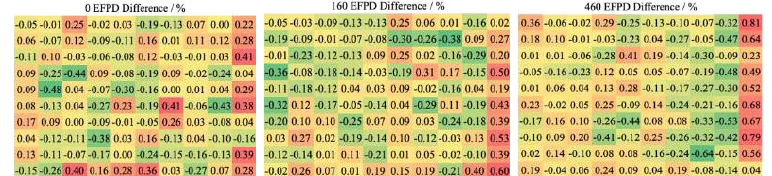
Figure 13. The mesh power and its difference for JRR-3M standard fuel assembly (1/4) with burnup